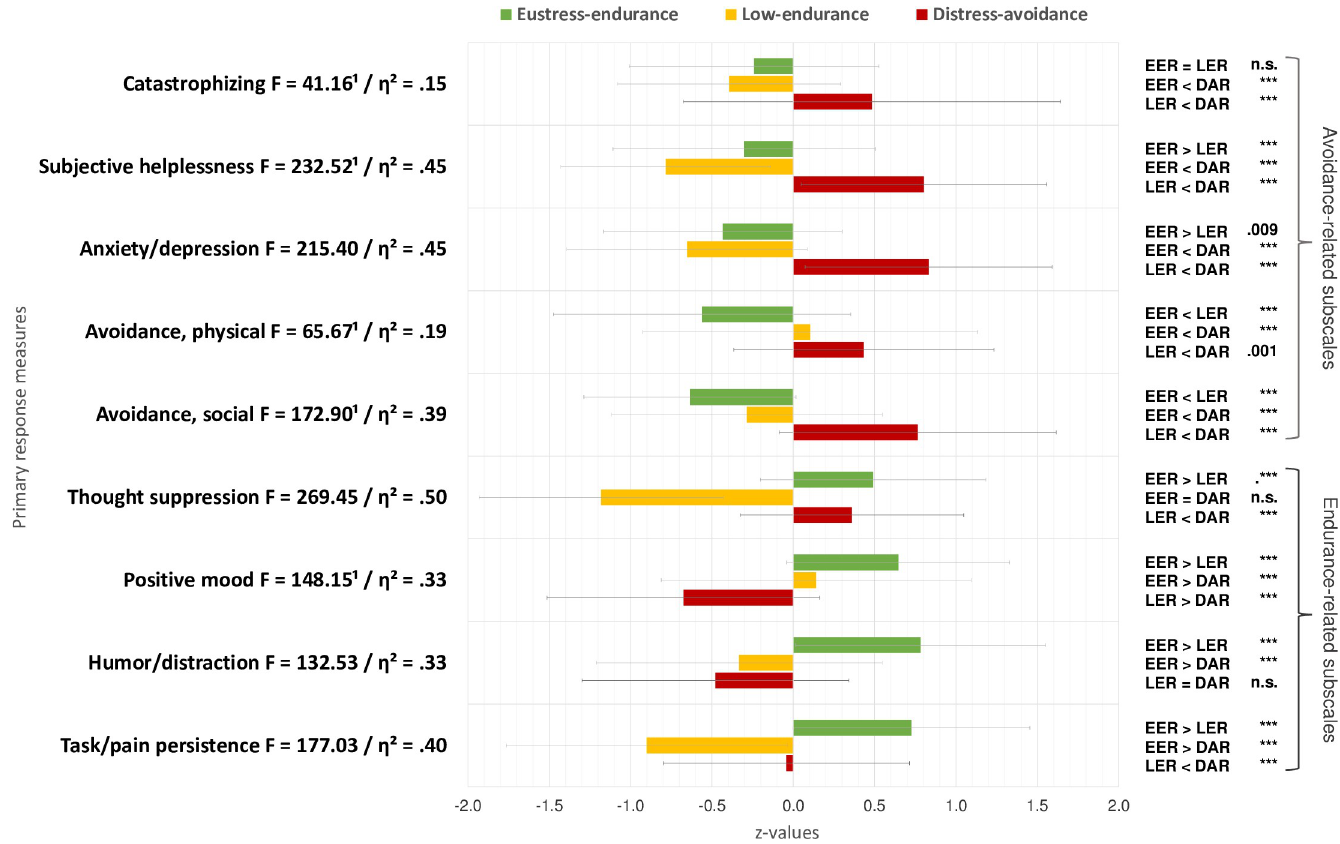
Fig 1. Z-standardized means, standard deviations, overall (ANOVAs) and multiple mean comparisons of pain response profiles on primary response measures. Note: n EER = 187, 35%, n LER = 141, 26%, n DAR = 208, 39%; EER = Eustress-endurance, LER = Low-endurance, DAR = Distress-avoidance responders; 1 = Welsh test; all overall p < .001; ��� = p < .001; η 2 classification of effect sizes by Cohen (1988): η 2 = .01, small, η 2 = .06, medium, η 2 = .14, large.